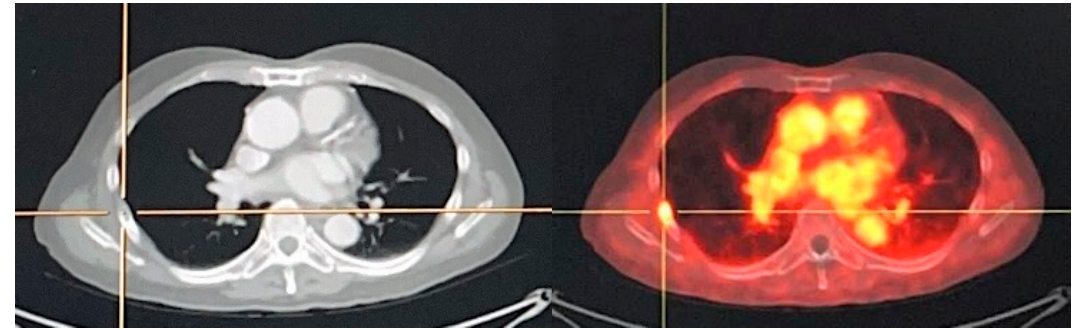
Figure 4. An example of nonspecific bone uptake. 18 F-PSMA PET/CT scan performed on a 71-year- old male with a history of 3 + 3 Gleason score PCa treated with radical prostatectomy (initial PSA levels of 6.3 ng/mL) for initial staging. PET/CT scan revealed a focal PSMA uptake at lateral aspect of right 6th rib (SUVmax of 5.08) without associated osteolytic/blastic lesion. Pathological report